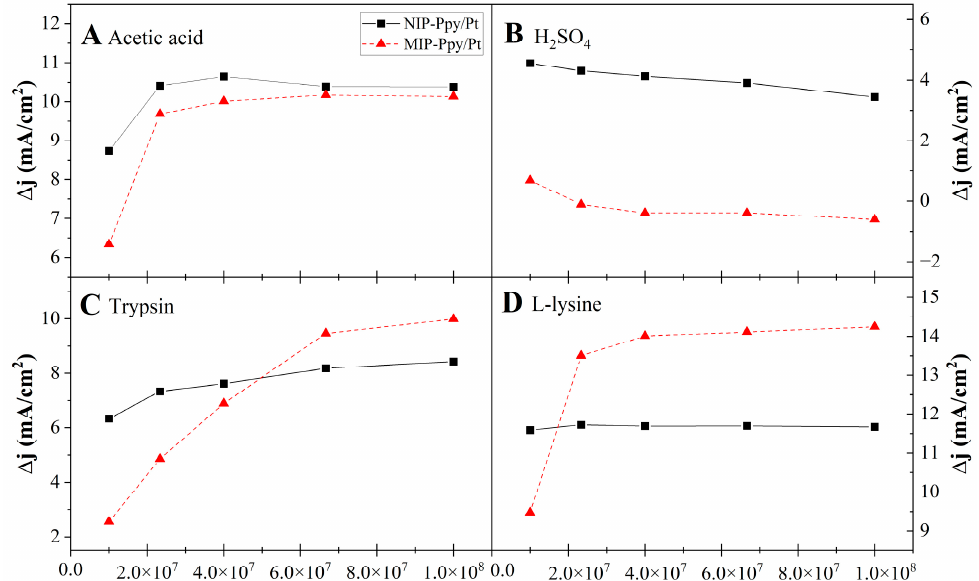
Figure 6. The current density of NIP-Ppy/Pt (solid black lines) and MIP-Ppy/Pt (dashed red lines) electrodes registered using pulsed amperometric detection after incubation in solutions containing different Listeria monocytogenes bacteria concentrations; Listeria monocytogenes from MIP-Ppy was extracted using different extraction solutions: ( A ) 10% acetic acid, ( B ) 0.05 M of sulphuric acid, ( C ) 10 U/mL of trypsin, ( D ) 0.1% L-lysine.